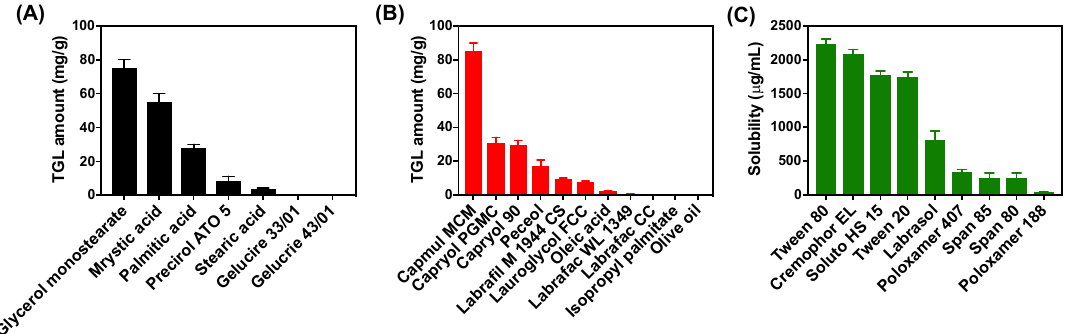
Figure 1. The solubility of ticagrelor (TGL) in ( A ) solid lipids, ( B ) liquid lipids, and ( C ) 1 w / v % surfactant solutions. Data are expressed as the mean ± SD (n = 3).